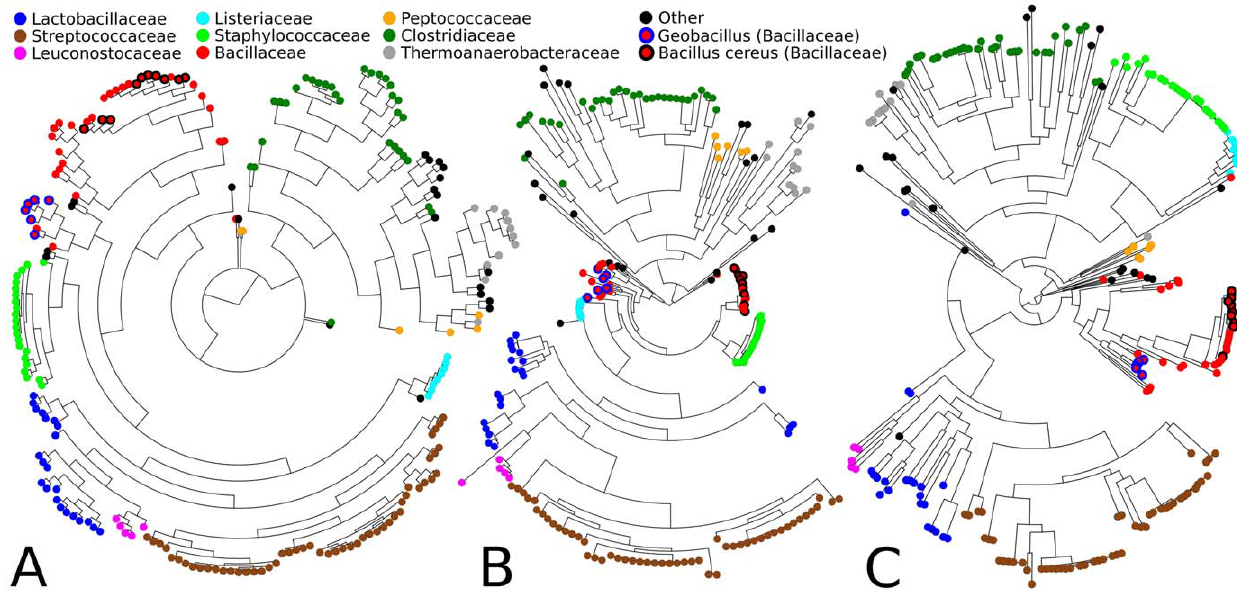
Figure 4. Firmicutes phylogenies obtained using functional clustering, 16S rRNA gene sequence, or core gene sequence. Colored leaves represent taxonomic orders. Trees generated using (A) functional similarity of COGs as detailed in Figure 2, (B) 16S rRNA gene similarity, and (C) core gene sequence similarity (for excinuclease ABC subunit A, the only core gene found for Firmicutes ). Note that while overall tree structure is comparable for the three methods, functional phylogeny and the excinuclease ABC subunit A core gene sequence correctly assign organize the Bacillus cereus group with other Bacillus and Geobacillus genera within the Bacillaceae .